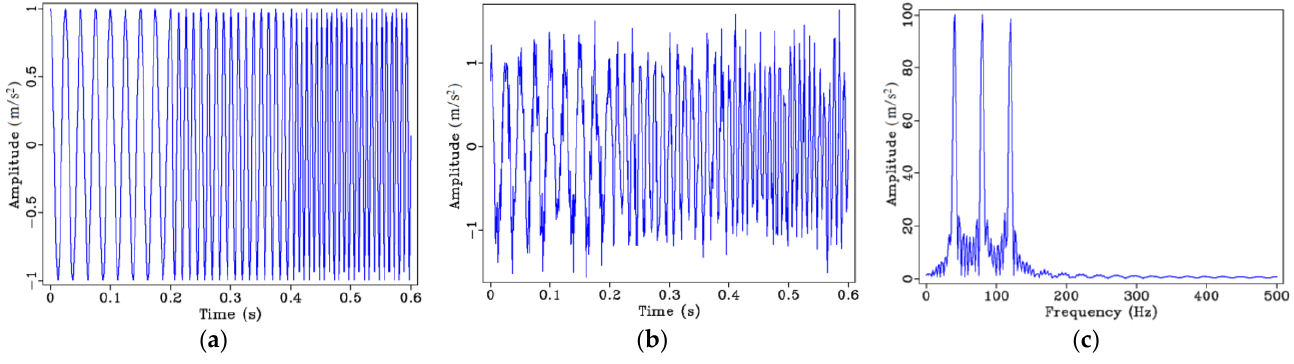
Figure 1. Constant-frequency step signal: ( a ) Time domain signal; ( b ) time domain signal with 10% random noise; ( c ) frequency spectrum of ( a ).